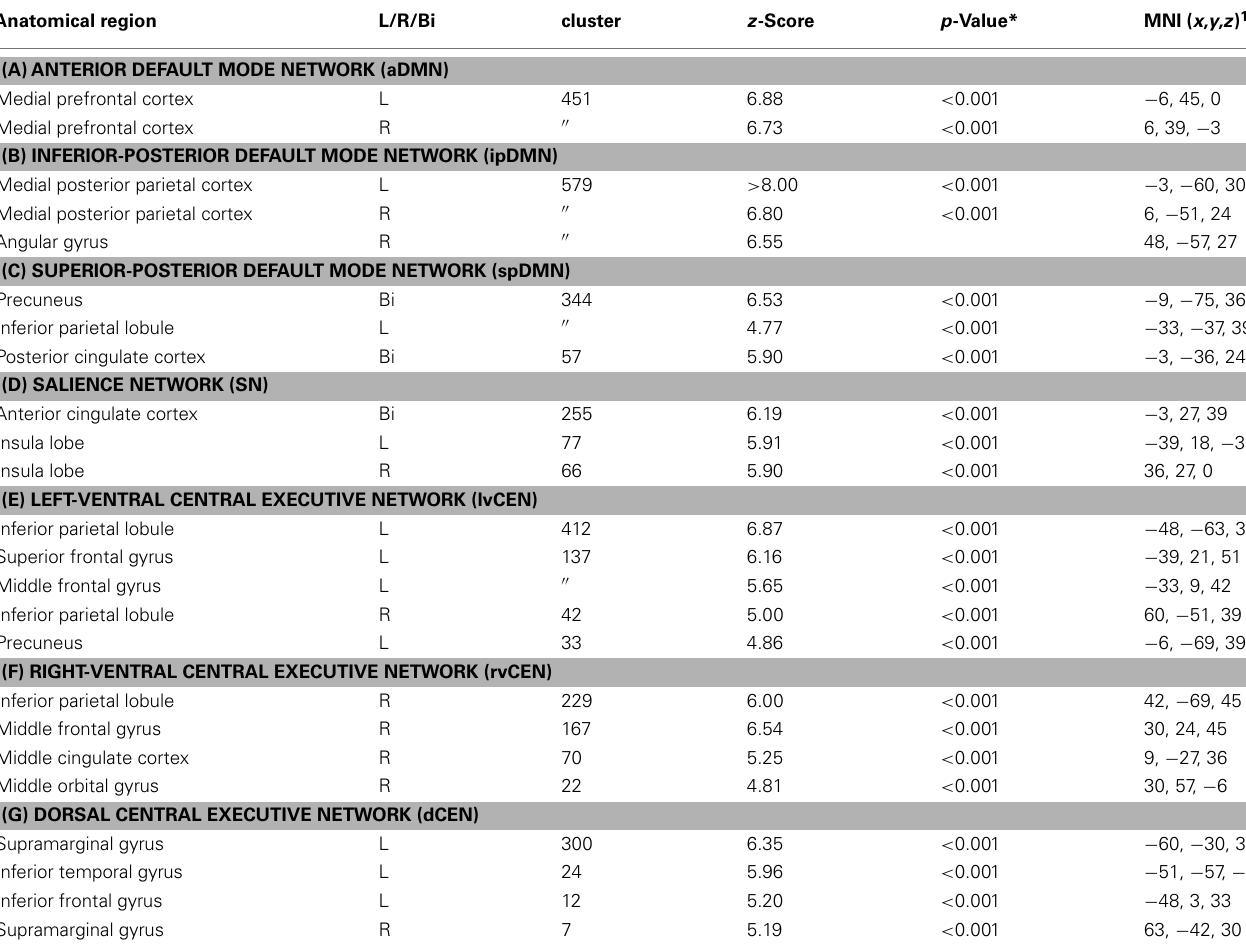
Table 3 | Intrinsic connectivity networks in healthy